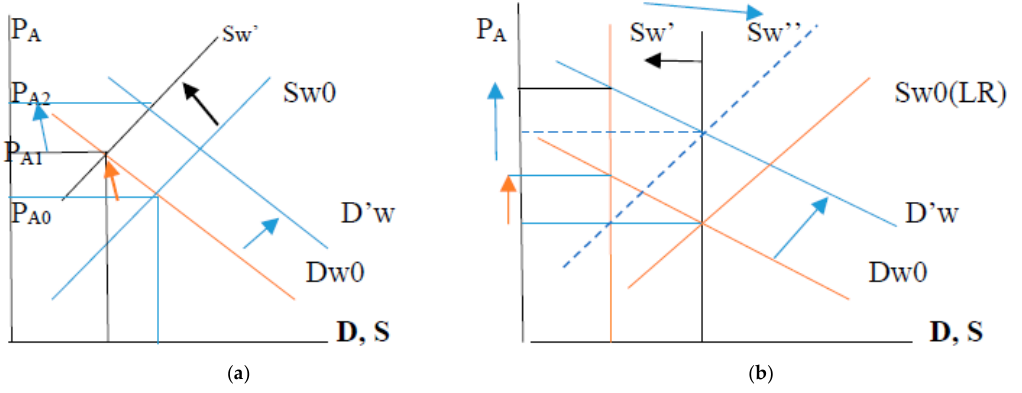
Figure 5. ( a , b ) Long-run and short-run adjustments with adverse supply shock in food and favorable demand effects. Source: Authors’ construction. As world food prices shift up and demand remains the same (or even rises), some economies quit CF, and supply responds until the price comes back to the previous level.